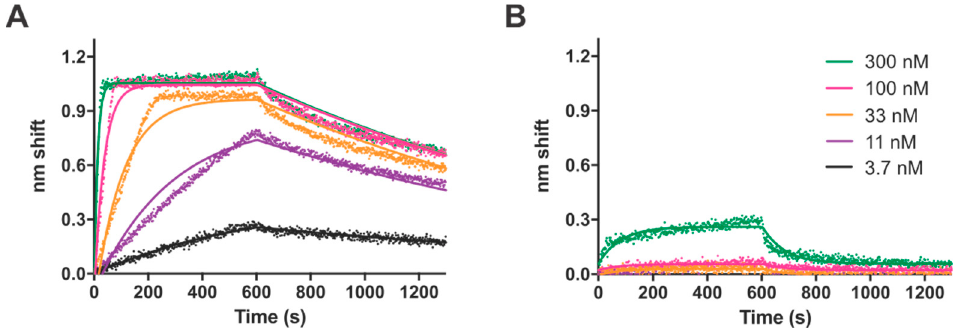
Figure 4. Biolayer Interferometry (BLI) analysis of TTHB023-DNA binding. Shown are raw traces (dots) and best-fit lines of TTHB023 binding to ( A ) ST2_B023_R6_wt consensus DNA or ( B ) REPSAis control DNA. TTHB023 concentrations investigated include 300 nM (green), 100 nM (magenta), 33 nM (gold), 11 nM (violet), and 3.7 nM (black). Table 1. TTHB023-DNA binding parameters.